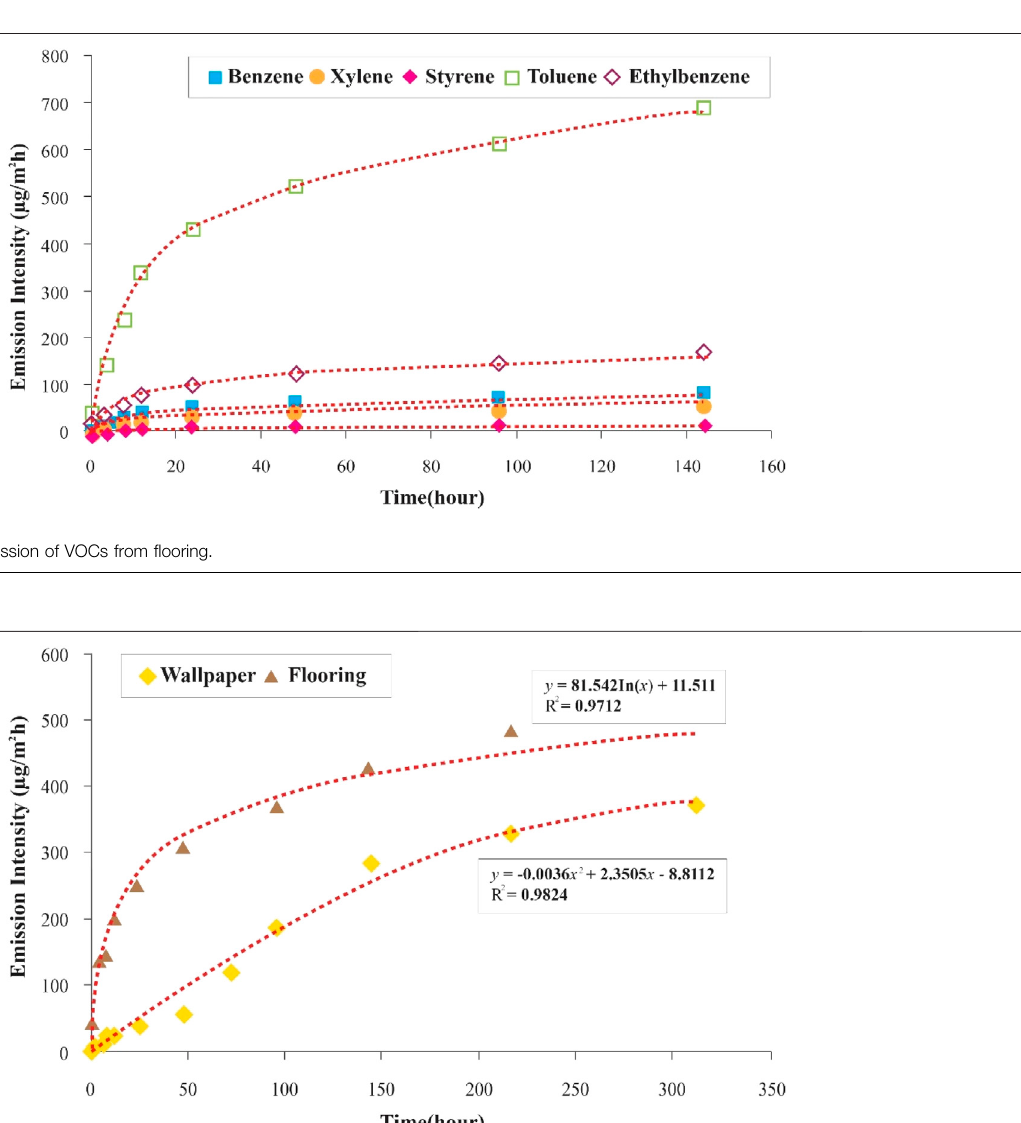
Frontiers in Built Environment |